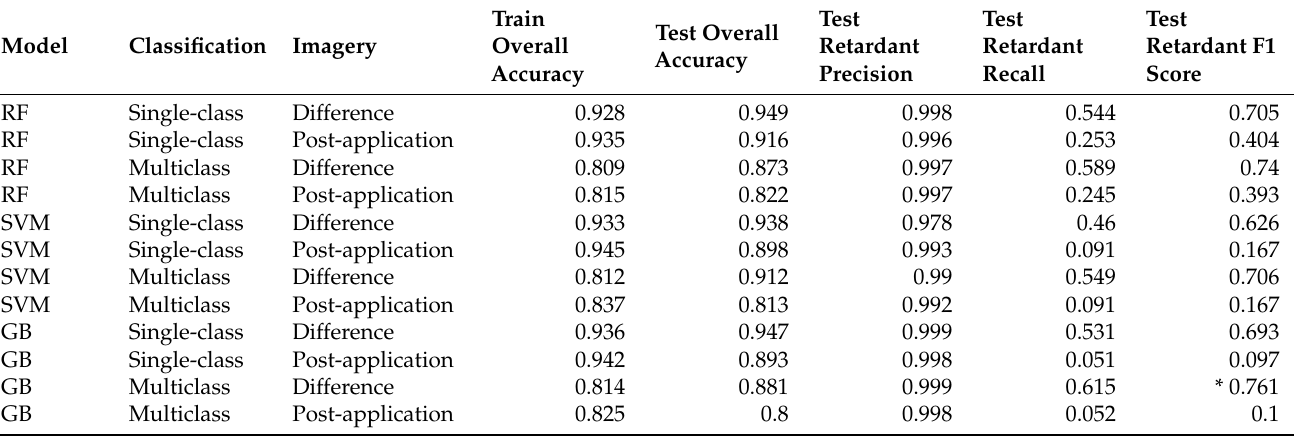
Table 2. Model testing results with different data scenarios: binary, multiclass, post-application, and pre- and post-application difference images (* denotes the best model).